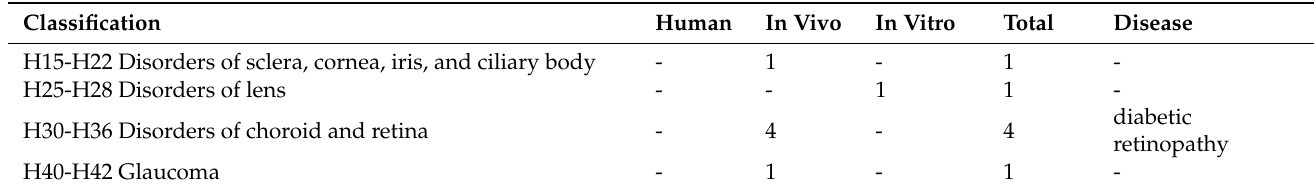
Table 16. The statistics of pharmacological results and its major diseases of SMC by experimental type in VII Diseases of the eye and adnexa of